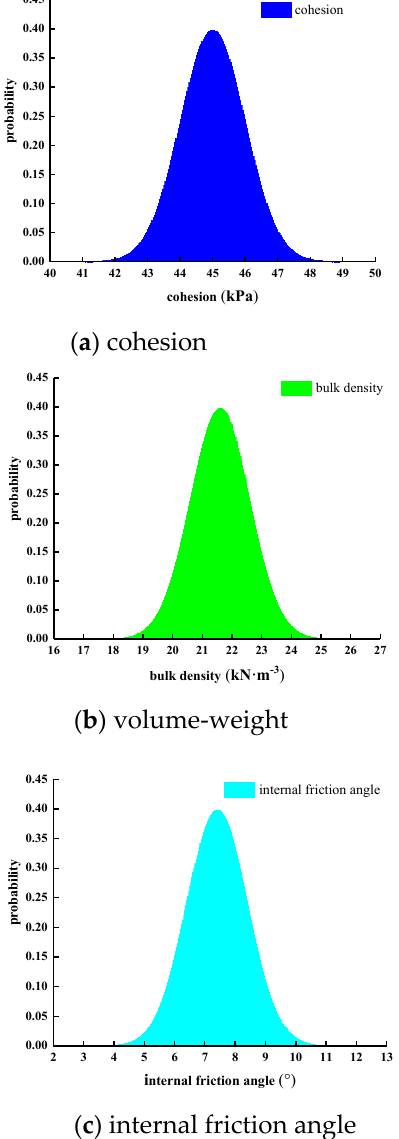
Figure 12. Probability density function distribution of clay layer.